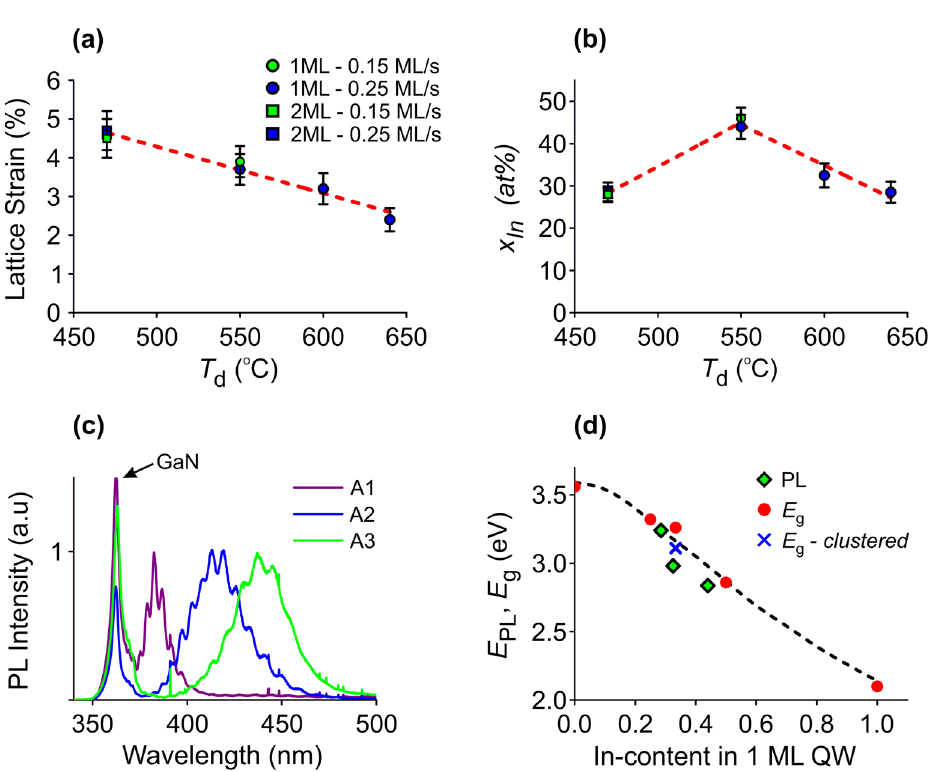
Figure 5. Collective results obtained from the quantitative HRSTEM image analysis and PL measurements. l ( a ) Lattice strain, ε z , with respect to the QW deposition temperature T d , showing linear trend. ( b ) Indium alloy content x In with respect to T d . Trendlines are guides to the eye. (Labels in ( a ) and ( b ) indicate the observed QW thickness and the N*-limited growth rate.) ( c ) Normalized 300 K PL spectra from the samples of series A. ( d ) Peak PL energy of the samples of series A, as a function of the QW indium content (green symbols). The red symbols are theoretical predictions of energy gap extrapolated from the calculations of Ref. 7 , and the blue symbol is the theoretical extrapolation of 33% indium content with indium